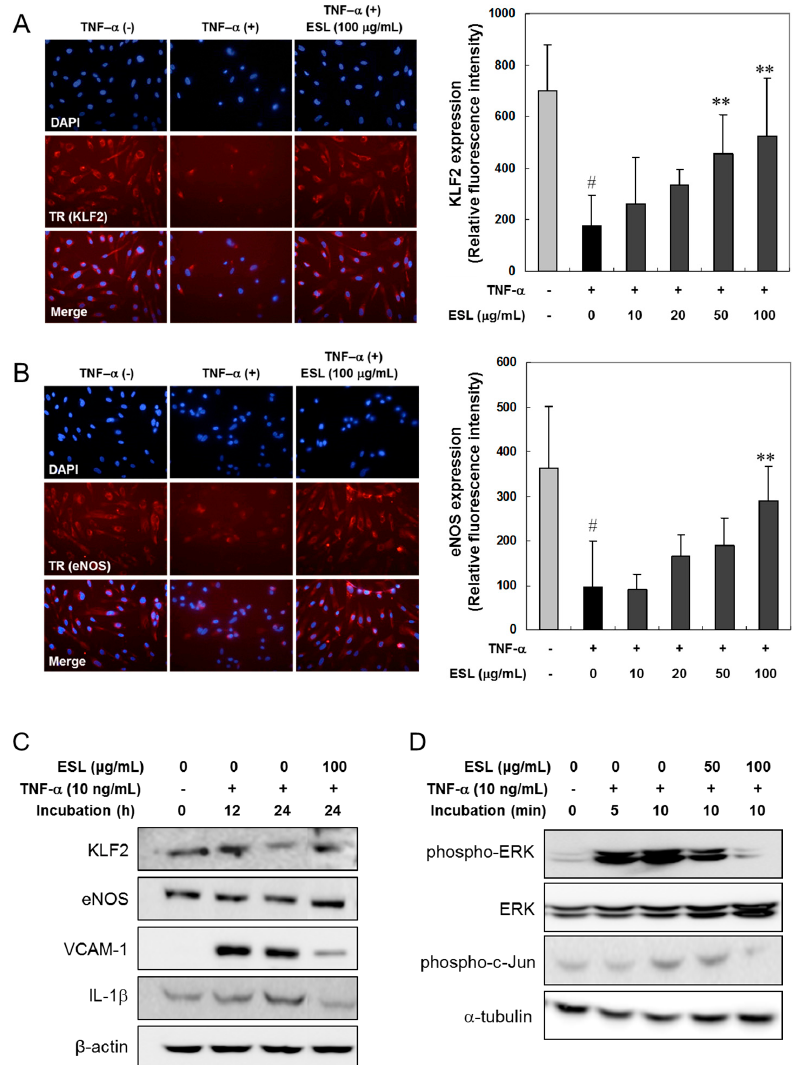
Figure 2. Effects of ESL on the suppression of KLF2 and eNOS, and Western blot analysis of target proteins and phosphorylation of ERK and c-Jun in TNF- α -stimulated HUVECs. ( A , B ) The cells were pretreated with or without ESL at the indicated concentrations for 2 h, and then stimulated with 10 ng/mL TNF- α for 24 h. The expression of KLF2 and eNOS was visualized by immunocytochemical (photographs, 400×) and immunofluorescence analyses. The cells were stained with antibodies directed against KLF2 and eNOS, and KLF2 and eNOS expression was detected with Texas Red (TR) or fluorescein isothiocyanate (FITC)-conjugated secondary antibodies using fluorescence microscopy. The bar graphs represent quantitative results obtained using a spectrofluorometer at excitation and emission wavelengths of 485 and 535 nm, respectively. # p < 0.01 vs. untreated group. ** p < 0.01 vs. the TNF- α -treated group; ( C , D ) The cells were pretreated with or without ESL at the indicated concentrations for 2 h and then stimulated with 10 ng/mL TNF- α for the indicated incubation times. The total cell extracts ( C ) and cytoplasmic extracts ( D ) were subjected to 10% SDS-PAGE and Western blot analysis with the respective primary antibodies.